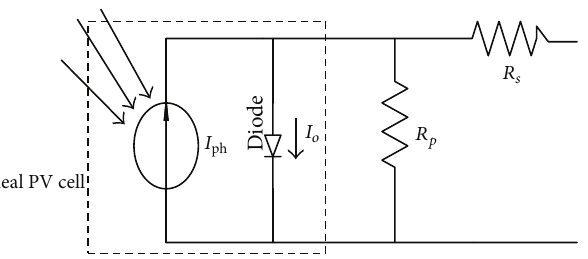
Figure 1: Circuit configuration of single diode PV